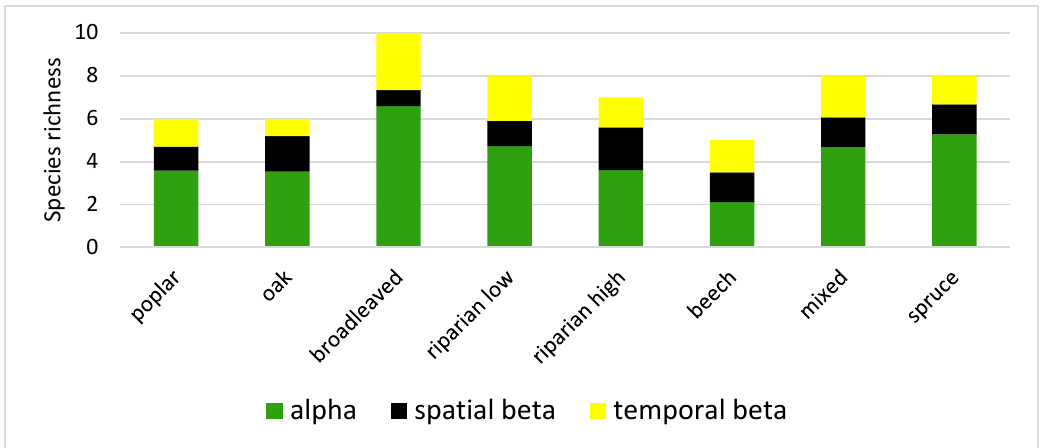
Figure 5. Partitioning of species richness of the surveyed forest types (gamma diversities) into local diversity at the level of forest plots (alpha), species turnover among plots of the same forest type (spatial beta), and species turnover among survey years of the same forest type (temporal beta).